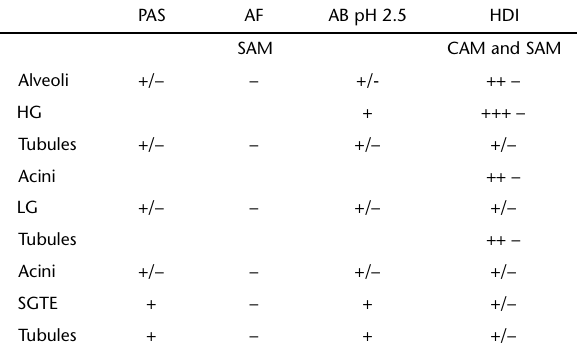
Table 2. Histochemical analysis of the HG, LG and SGTE in European Bison. (HG) Harderian gland, (LG) lacrimal gland, (SGTE) superficial gland of the third eyelid; Staining: (PAS) periodic acid- Schiff, (AB pH 2.5) Alcian blue pH 2.5, (HDI) Hale’s dialysed iron, (AF) aldehyde fuchsin, (SAM) sulfated acid mucosubstances, (CAM) carboxylated acid